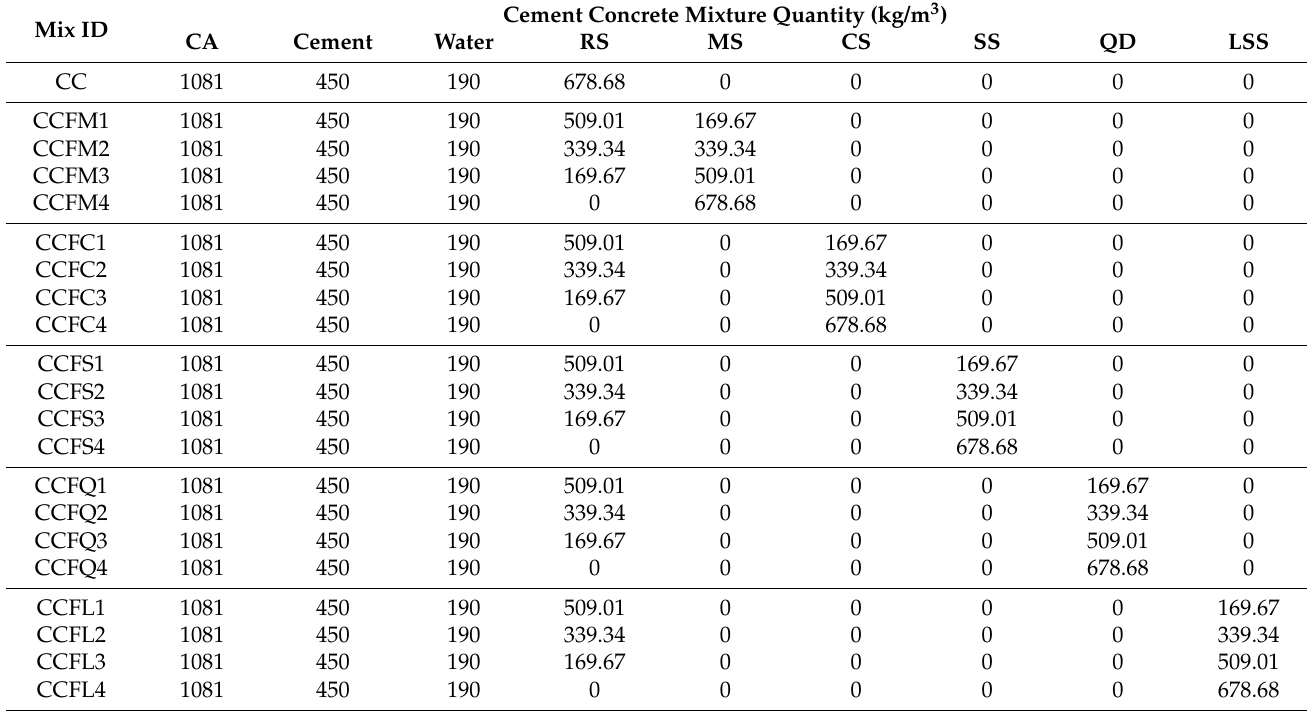
Table 5. Mix Proportion for M40 cements concrete with various soil